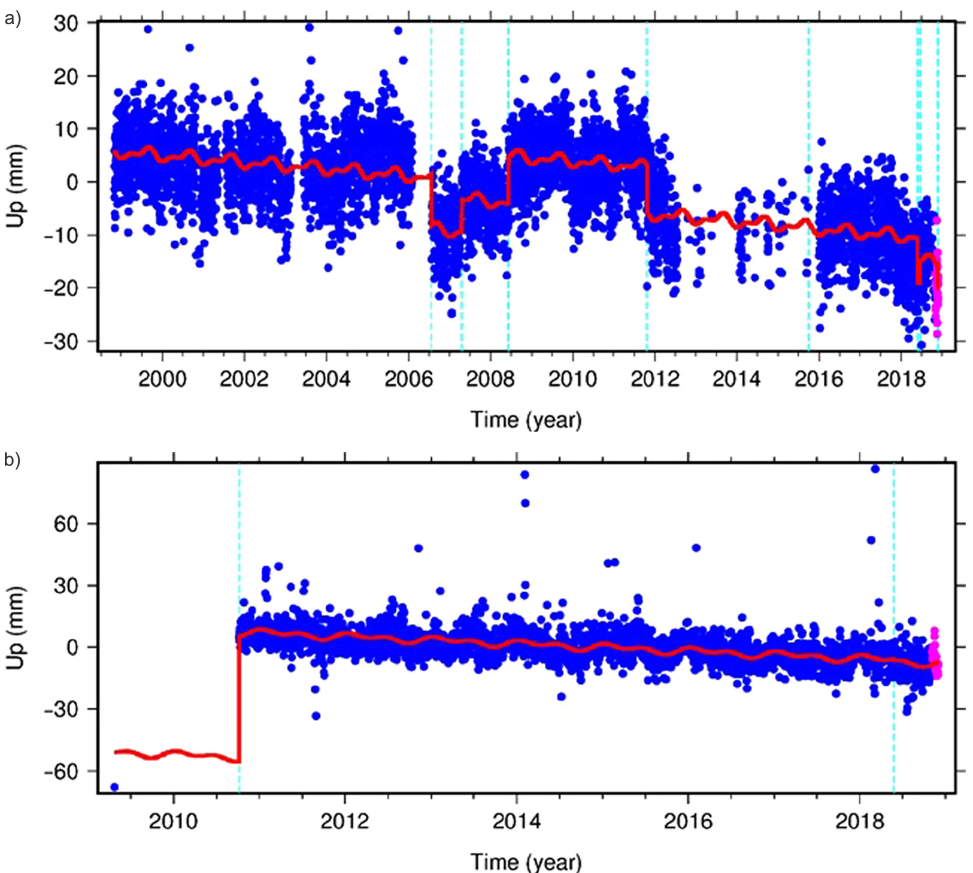
Fig. A.1.1. GPS position time series for the GPS antenna near the tide gauges of a) The Battery, New York and b) Brest. Images reproduced and modified after